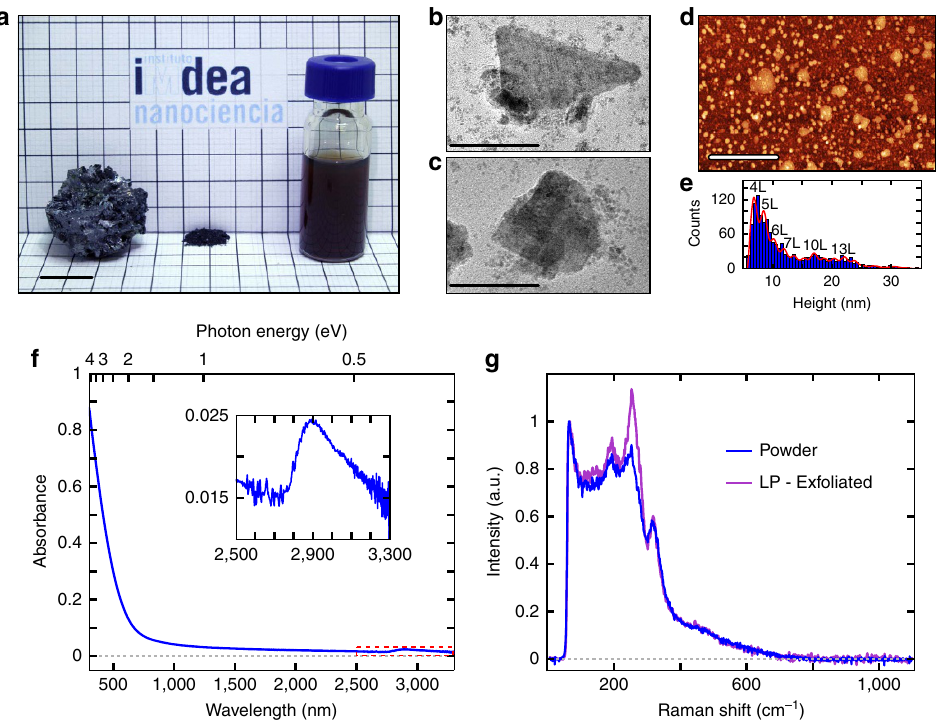
Figure 3 | Liquid phase exfoliation of franckeite. ( a ) Franckeite samples. Left: bulk mineral; middle: powder material obtained after grinding of raw chips; right: suspension of exfoliated material prepared by sonication of a 100mg (cid:2) ml (cid:3) 1 powder dispersion in NMP. The scale bar is 1cm. ( b , c ) TEM images of representative franckeite nanosheets prepared by exfoliation of a 100mg (cid:2) ml (cid:3) 1 powder dispersion in NMP. The scale bars are 150 and 75nm, respectively. ( d ) AFM topographic characterization of franckeite nanosheets obtained from the exfoliation of a 1mg (cid:2) ml (cid:3) 1 powder dispersion in isopropanol/water 1/4 (v/v). The scale bar is 2 m m. ( e ) Statistical analysis of the AFM raw height data. The inserted numbers indicate the corresponding number of layers (unit cell, H þ Q layer, 1.7nm in thickness) from B 4 layers (4L) up to B 13 layers (13L). ( f ) UV-Vis-NIR spectrum of a thin film of franckeite colloidal suspension deposited on a glass slide; the sample originates from the liquid-phase exfoliation of a 100mg (cid:2) ml (cid:3) 1 franckeite powder dispersion in NMP. Inset: zoom of the region indicated by a dashed red line that highlights the absorption peak around 2,900nm. ( g ) Raman spectra of franckeite raw powder (blue line) and liquid-phase (LP)-exfoliated franckeite obtained from the sonication of a 100mg (cid:2) ml (cid:3) 1 powder dispersion in NMP (pink